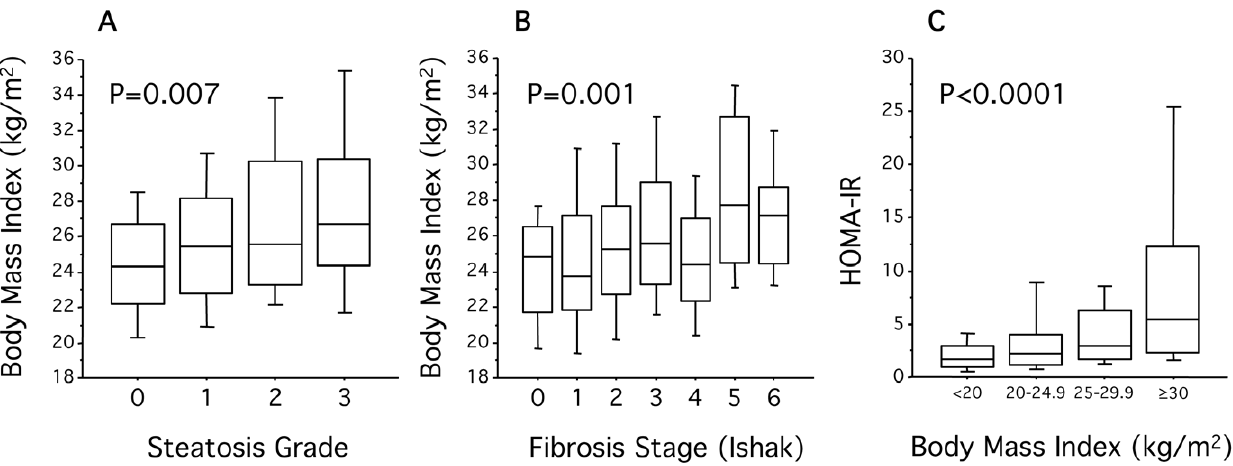
Figure 1. Impact of BMI on baseline histopathology and HOMA-IR. Box plots displaying the 10 th , 25 th , 50 th , 75 th , and 90 th percentiles of BMI among patients grouped by steatosis grade (A; n=279) and fibrosis stage (B; n=279), as well as HOMA-IR among patients grouped according to BMI (C; n=268). P-values obtained using Kruskal-Wallis test.